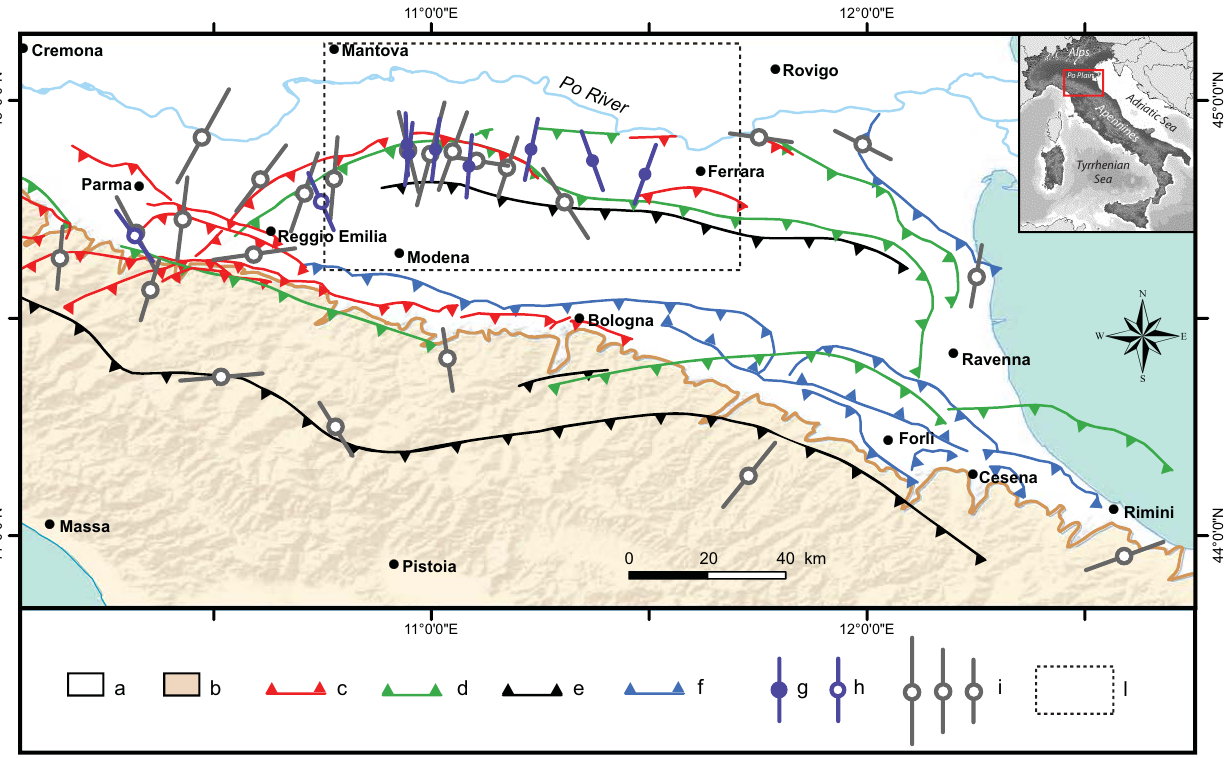
Fig. 1. Schematic structural setting of the southern Po Plain (main buried structures after Boccaletti and Martelli, 2004) with orientation of maximum horizontal stress from focal mechanisms of the Emilia 2012 earthquake sequence (Scognamiglio et al., 2012) and from the Italian present-day stress map (Montone et al., 2012). (a) Po Plain units (Plio–Quaternary); (b) Apenninic Units (Meso–Cenozoic); (c) active and recent ( < 1My) shallow thrusts; (d) active and recent thrust fronts in the Meso–Cenozoic carbonatic sequence; (e) active and recent thrust fronts in the basement; (f) reactivated thrust fronts of the Pliocene–Early Pleistocene (4.5–1My); (g) maximum horizontal stress orientation from earthquake focal mechanisms of M ≥ 5 . 0 events of the Emilia 2012 sequence; (h) maximum horizontal stress orientation from past earthquakes ( M w 5.0 Parma 1983 and M w 5.4 Reggio Emilia 1996); (i) maximum horizontal stress orientation from borehole breakouts (scaled by quality); (l) area of Fig.